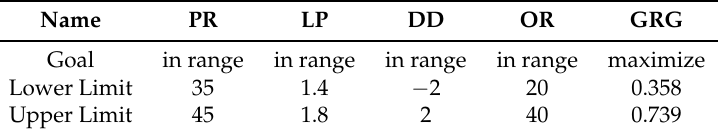
Table 14. Objectives and constraints for response surface models.